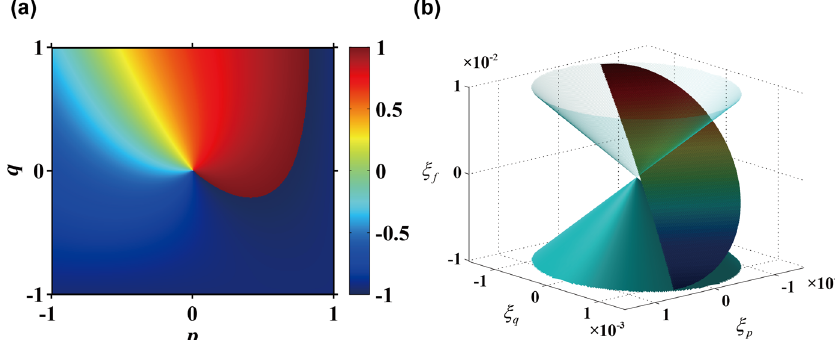
9. (a) The reflection phase in the p - q space for the PCs with d a ¼ 97 nm and d b ¼ 72 nm. Now the PCs are truncated at the starting plane of the first layer. The working frequency is also fixed at the frequency of the Weyl point, which is f w ¼ 247 . 6 THz. Compared with Fig. 3(a), the reflection phase in the p - q space changes locally, but the charge of the vortex located at the Weyl point stays the same. (b) The dispersion of the interface states near a Weyl point, where the cyan cone represents the bulk state and the colored sheet represents the interface states. Color code of the interface states represents different frequencies. In this calculation, the photonic crystals are truncated at the starting plane of the first